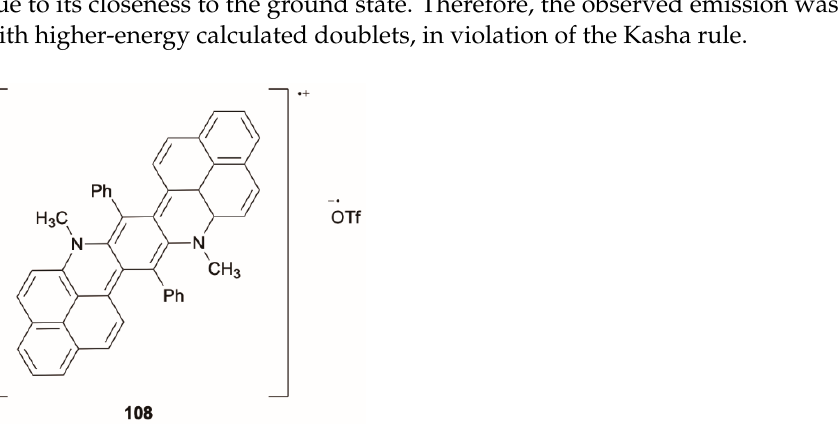
Figure 30. Measured energy levels from spectral onsets of 109 in solvents of different polarity. The green band represents the energy range over which solvatochromic states were observed. Red ar- rows represent nonradiative transitions. Adapted with permission from [89], Copyright 2021, Amer- ican Chemical Society, https://pubs.acs.org/doi/10.1021/acs.jpclett.0c03314 (accessed on 8th July 2021). Further permissions related to the material excerpted should be directed to the American Chemical Society. 9. Conclusions This review of the literature of the past 10 years collects examples of purely organic compounds exhibiting photophysical behaviors that violate the Kasha rule. Mechanisms involved in different systems are frequently related to the same molecular properties, which are a large E n -E n − 1 energy gap, a strong E n -E 0 oscillator strength and a weak E n − 1 -E 0 oscillator strength ( n > 1), where E refers to both singlet and triplet levels. Moreover, sym- metry considerations on E n and E n − 1 have to be taken into account, together with the en- ergy gap ones, as a factor that inhibits E n -E n − 1 IC, making the radiative deactivation from E n competitive. From the collected examples it appears that even a Δ E(E n -E n − 1 ) as small as 0.35 eV is enough to favor emission from E n . This value is derived from computational studies, some of which can be of course further improved. However, at this stage, a Δ E(E n - E n − 1 ) smaller than the generally accepted 1 eV limit could be enough to observe anti-Kasha emission. Alternatively, thermally activated anti-Kasha behavior may occur in the presence of a small E n -E n − 1 energy gap (about 0.2 eV) by both reverse IC and reverse ISC. In addition to basic research considerations, anti-Kasha behavior might offer im- proved performances useful for many practical applications. Among them, dual fluores- cence from S 2 and S 1 and/or phosphorescence from T 2 and T 1 allow the development of OLEDs with dual electroluminescence based on a single compound, strongly simplifying device technology and concomitantly reducing fabrication costs. Other interesting issues are the intrinsic response of dual emitters to external stimuli such as temperature, allow- ing their use as fluorescence thermometers, or water, being optimal as humidity sensors, or encryption/decryption. The different lifetimes of their emitting states offer unprece- dented opportunities for their use in time-resolved bio-imaging, solving the problem of detection in weak emission areas. Author Contributions: Writing—review and editing: D.M., E.L., C.G., A.F., C.B. and E.C. All au- thors have read and agreed to the published version of the manuscript.